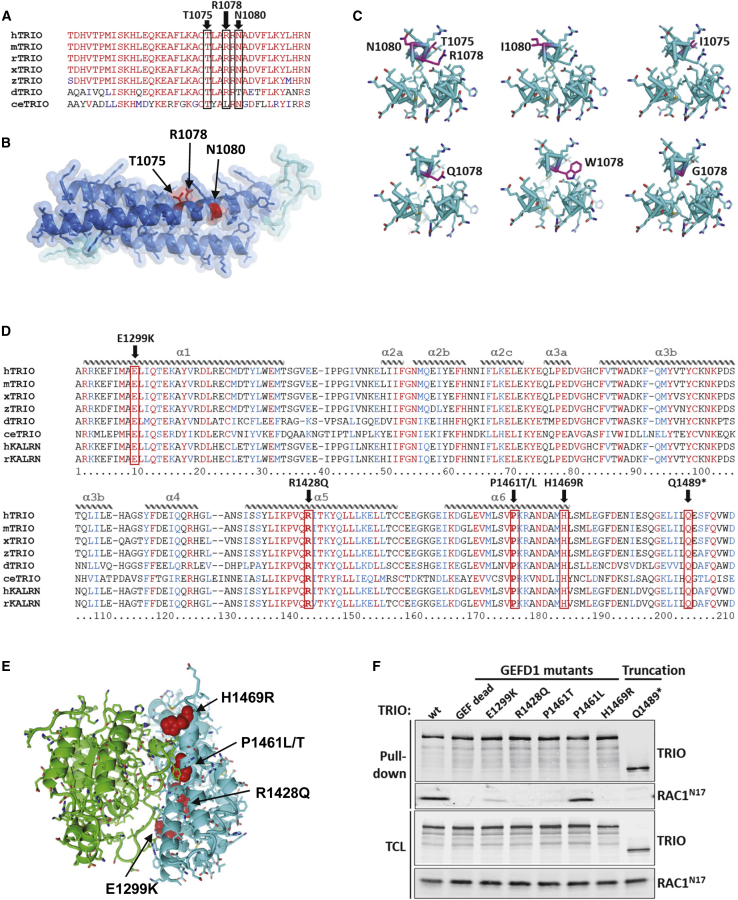
Mapping of the Mutation Sites on the 3D Structure of the TRIO Spectrin 7 Repeat Domain and GEFD1(A) Species conservation of the residues in TRIO’s seventh spectrin repeat, which is mutated in neurodevelopmental diseases. Identical residues are labeled in red, and similar residues are in blue. The positions of the residues p.Thr1075, p.Arg1078, and p.Asn1080 are boxed in black and indicated on top of the sequence, which encompasses amino acids 1053 to 1091, corresponding to the second α helix of the spectrin repeat. Represented species are Homo sapiens (h), Mus musculus (m), Rattus norvegicus (r), Xenopus laevis (x), Danio rerio (z), Drosophila melanogaster (d), and Caenorhabditis elegans (ce).(B) Lateral view of the structural model of the seventh spectrin repeat of TRIO. The spectrin domain was modeled based on the crystal structures of human beta2-spectrin (PDB ID 3EDV30) with our sequence alignment and SWISS-MODEL server.32 Parts of the structure that were modeled with high and low confidence are in blue and cyan, respectively. Mutations within the spectrin domain seen in affected individuals are indicated in red.(C) Axial view of the cross section of the structure at the site of the mutations. Mutations are indicated in magenta.(D) Sequence alignment of the RAC1-specific DH1 domain of TRIO (and KALIRIN) across evolution. Identical residues are labeled in red and similar residues are labeled in blue. The α helices are depicted schematically on top of the sequence alignment. The positions of the alterations p.Glu1299Lys, p.Arg1428Gln, p.Pro1461Leu, p.Pro1461Thr, and p.His1469Arg are indicated in bold and boxed in red. Each mutation affects a highly conserved residue within helices α-1, α-5, and α-6, which make contact with the target GTPase RAC1. Represented species are Homo sapiens (h), Mus musculus (m), Rattus norvegicus (r), Xenopus laevis (x), Danio rerio (z), Drosophila melanogaster (d), and Caenorhabditis elegans (ce).(E) Structure of the DH1 domain of TRIO (cyan) in complex with the small GTPase substrate RAC1 (green). Mutations within the DH1 domain seen in affected individuals are indicated in red and can be seen to occur at the protein-substrate interface. The complex was modeled with the crystal structures of DH1 (PDB: 1NTY) and the complex with substrate (PDB: 1KZ7). Figures of the protein structures were generated with PyMol.33(F) Most of the GEFD1 mutants are affected in their ability to bind to RAC1N17 (DN). Immunoblot analysis of a Streptavidin pulldown assay of biotinylated TRIO variants. HEK293T cells were transfected with the indicated biotinylated GFP-TRIO variants and RAC1N17. TRIO was pulled down with Streptavidin beads, and the co-precipitating RAC1N17 was detected with a RAC1 antibody.